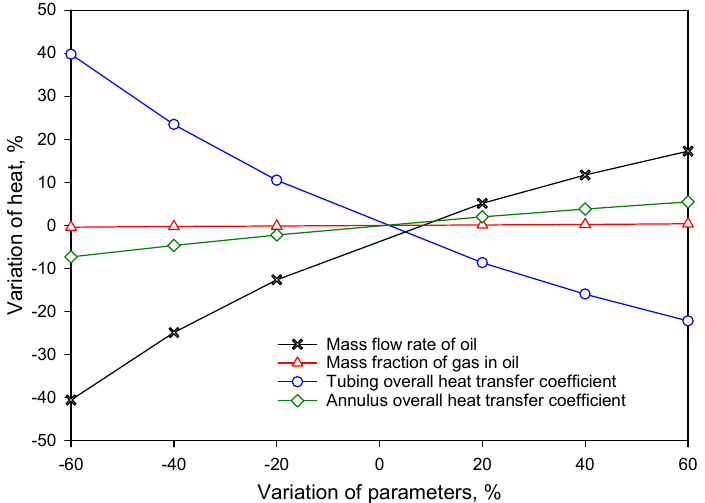
Figure 3. Effect of oil flow rate on the temperature distribution curve in the tubing.